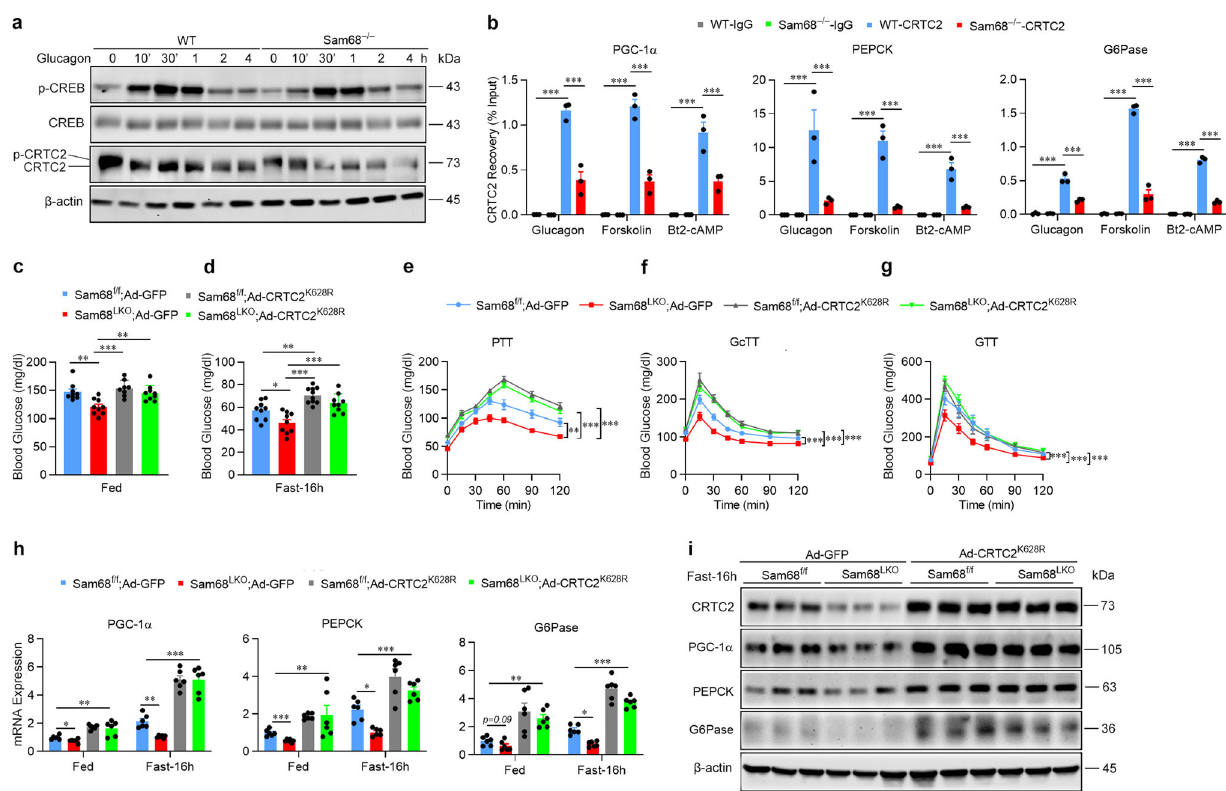
Fig. 3 Sam68 enhances glucagon signaling by inhibiting CRTC2 degradation. a WT and Sam68 − / − primary hepatocytes were treated with glucagon (100 nM) for 0 − 30 min and 1 − 4 h; then, protein levels of phosphorylated CREB (p-CREB), total CREB, and CRTC2 were evaluated via Western blot. b WT and Sam68 − / − hepatocytes were treated with glucagon, forskolin (10 μ M), or Bt2-cAMP (100 μ M) for 30 min; then, CRTC2 occupancy of the promoters for PGC-1 α , PEPCK, and G6Pase was evaluated via chromatin immunoprecipitation (ChIP) assay ( n = 3). c – i Sam68 LKO and Sam68 f/f mice were administered adenoviral vectors coding for GFP or a ubiquitination-defective CRTC2 K628R mutant (2 × 10 9 IFU per mouse). Four days later, blood glucose levels were measured ( c ) under feeding conditions (Sam68 f/f ; Ad-GFP, n = 9. Sam68 LKO ; Ad-GFP, n = 9. Sam68 f/f ; Ad-CRTC2 K628R , n = 8; Sam68 LKO ; Ad- CRTC2 K628R , n = 9), ( d ) after fasting for 16 h (Sam68 f/f ; Ad-GFP, n = 9. Sam68 LKO ; Ad-GFP, n = 9. Sam68 f/f ; Ad-CRTC2 K628R , n = 10; Sam68 LKO ; Ad- CRTC2 K628R , n = 9), and in the ( e ) pyruvate-tolerance test (PTT; Sam68 f/f ; Ad-GFP, n = 9. Sam68 LKO ; Ad-GFP, n = 9. Sam68 f/f ; Ad-CRTC2 K628R , n =